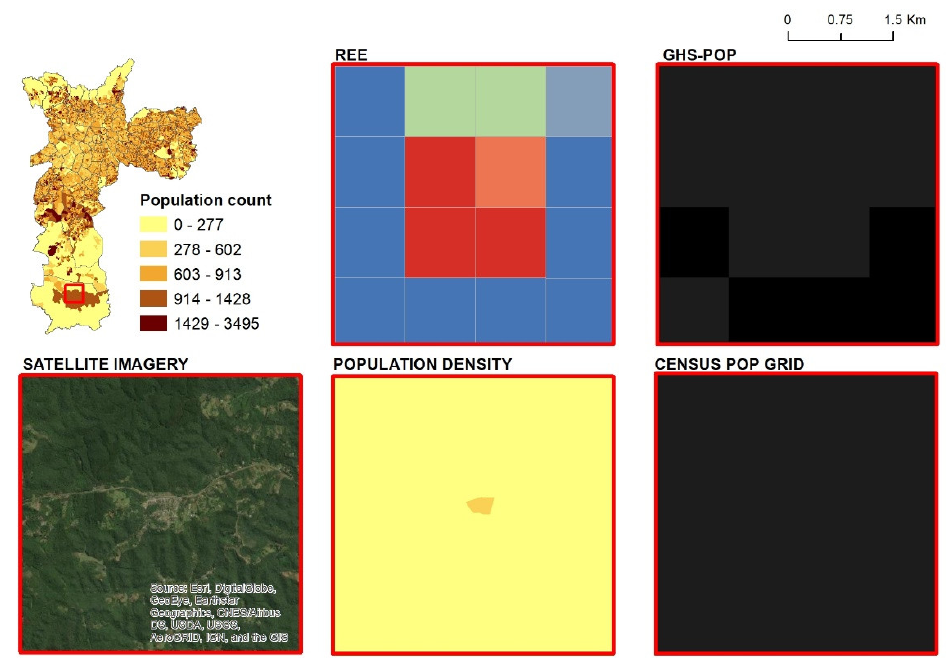
Figure 4. Sao Paulo, example of overestimation in a low-density area by the GHS-POP.